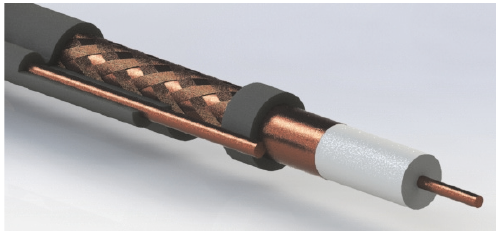
Figure 1: Axonometric cross section of the elongate SE. A copper wire runs parallel to a coaxial cable.